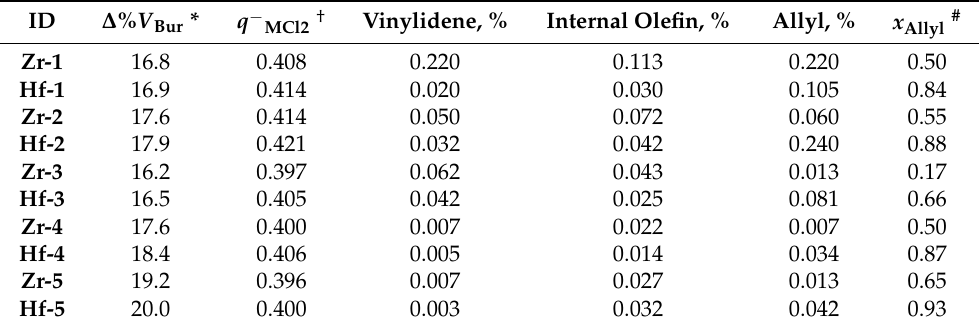
Table 2. NMR chain end analyses (as fraction of all monomeric units in %) of the polymers produced at T p = 100 ◦ C and p (C 3 H 6 ) = 7.9 bar with the five catalyst pairs ( M-1 to M-5 ) of Figure 1. ID ∆ % V Bur * q − MCl2